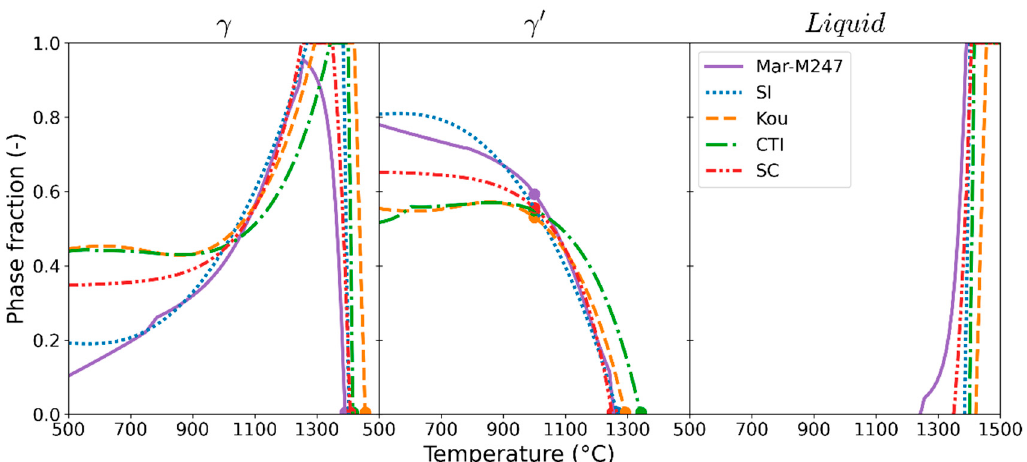
Figure 2. Phase fraction curves calculated with Thermo-Calc for liquid, γ , and γ′ phases depending on temperature for reference alloy Mar-M247 and selected alloys. Properties used to define deviation from Mar-M247 are marked with dots.